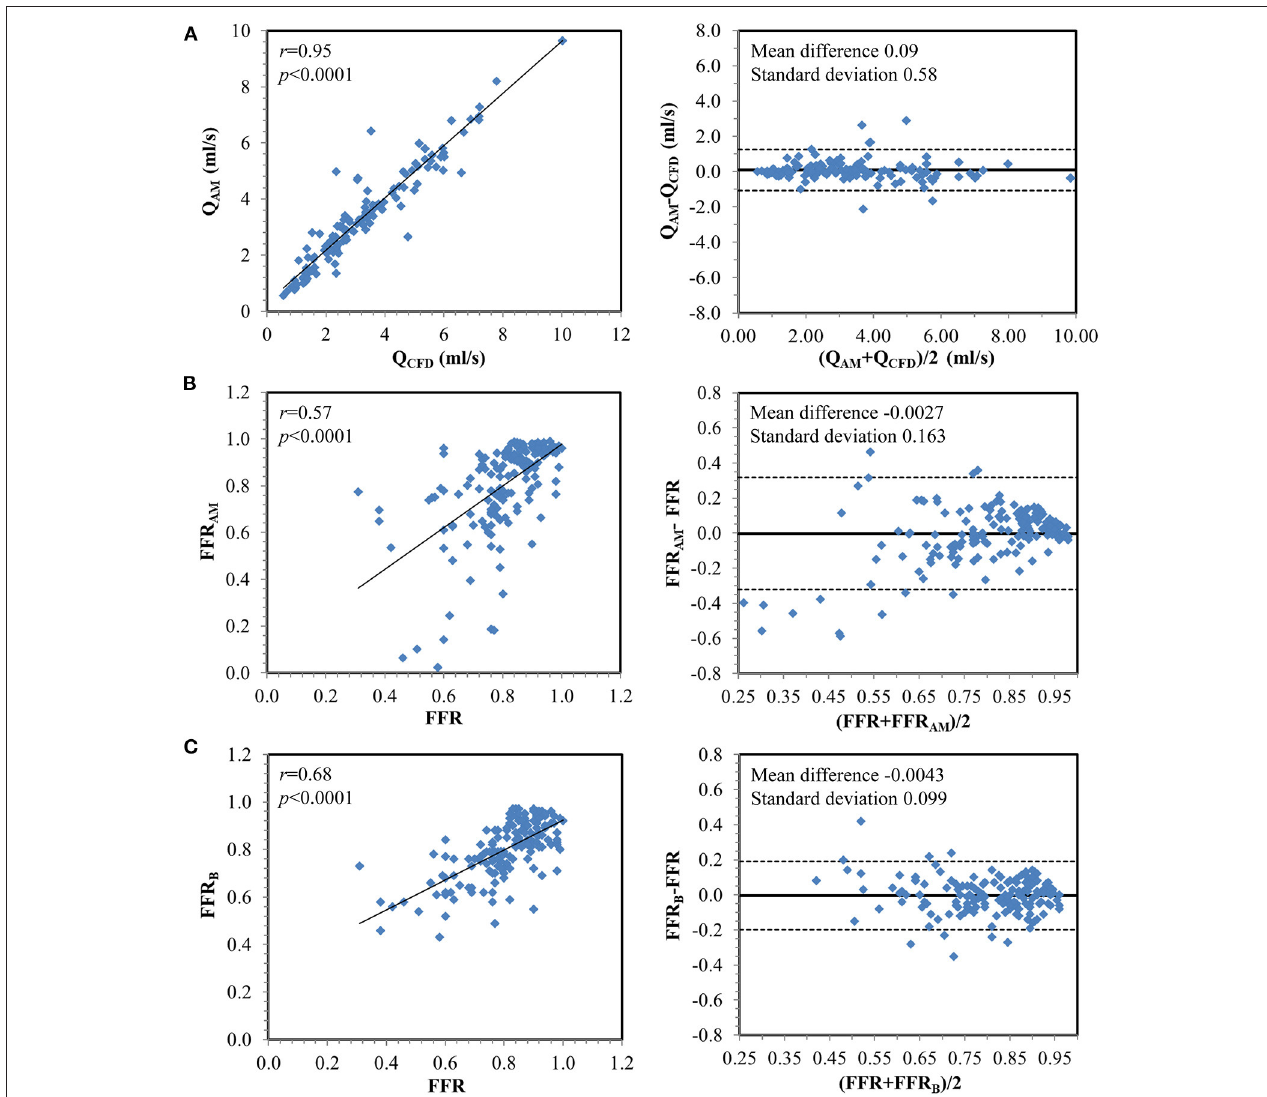
FIGURE 4 | Correlation and Bland–Altman plots (A) between flow rates calculated from computational fluid dynamics simulation ( Q CFD ) and estimated from the analytical model ( Q AM ) and between invasively measured fractional flow reserve (FFR) with (B) FFR AM and (C) FFR B on a per-vessel